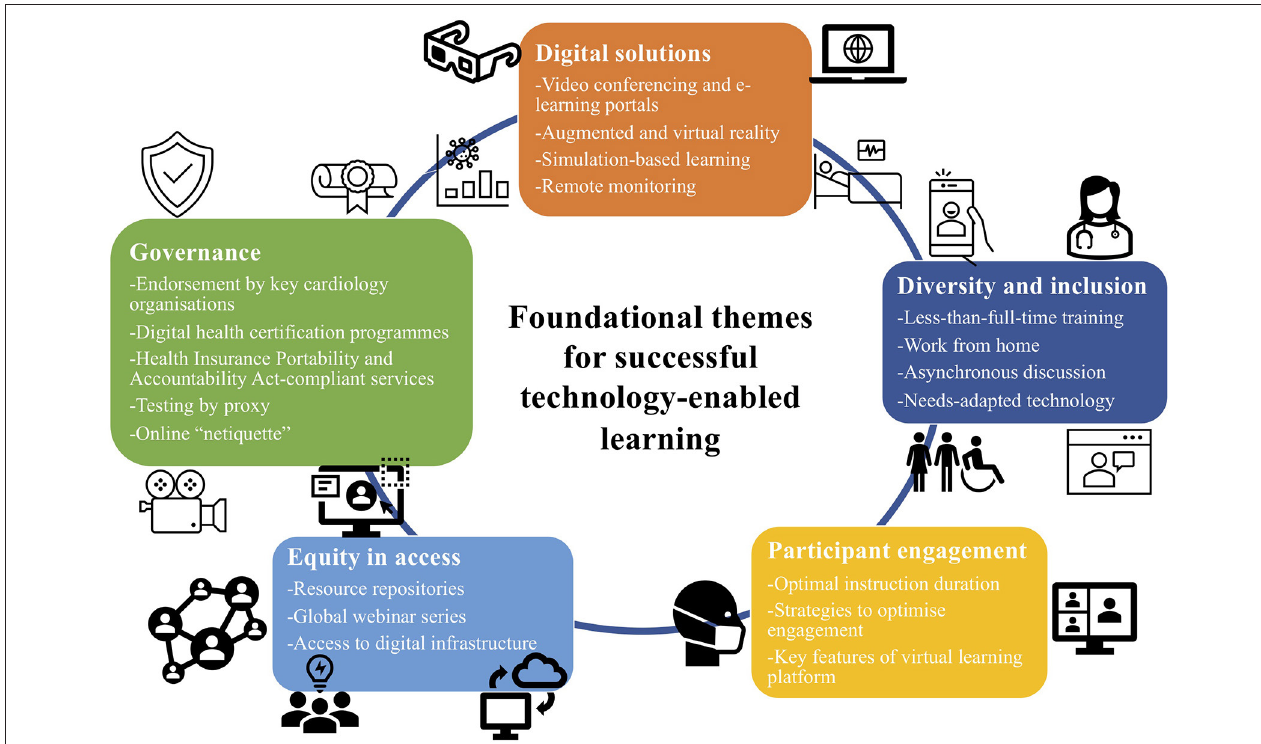
FIGURE 1 | Foundational themes for building a successful e-learning model in cardiovascular and general post-graduate medical